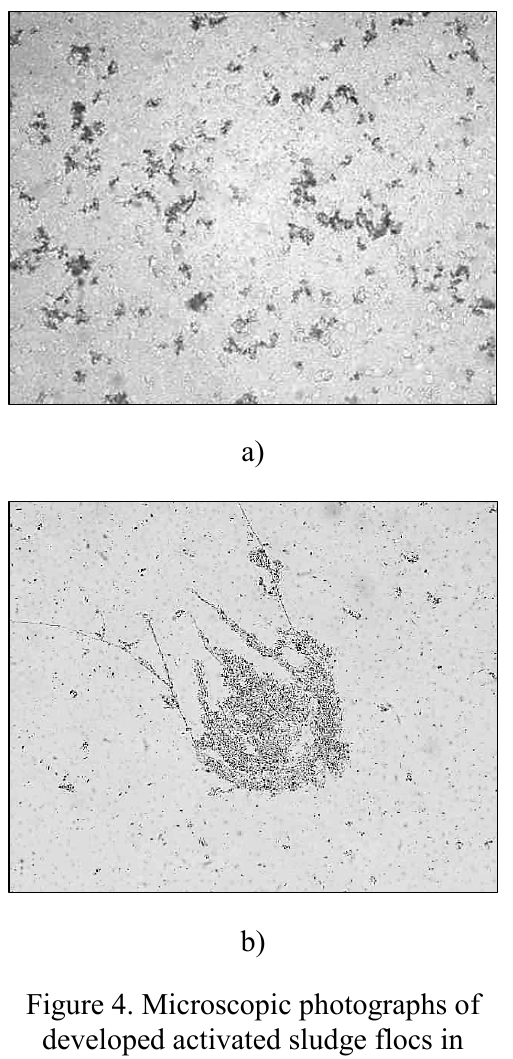
Figure 4. Microscopic photographs of developed activated sludge flocs in biodegradation process of leachate from biowaste, magnification 100×: a) 2 nd